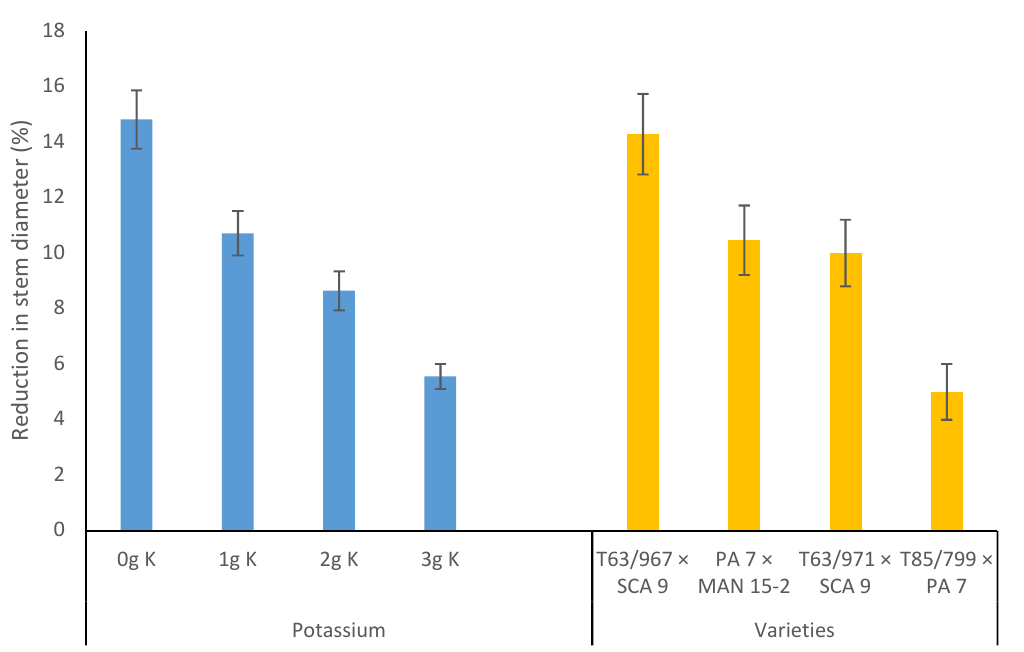
Figure 3. Reduction in stem diameter of cocoa seedlings under water-stress relative to well-watered conditions as affected by potassium application and varieties, 45 days from stress imposition. Bars represent standard error of the mean.